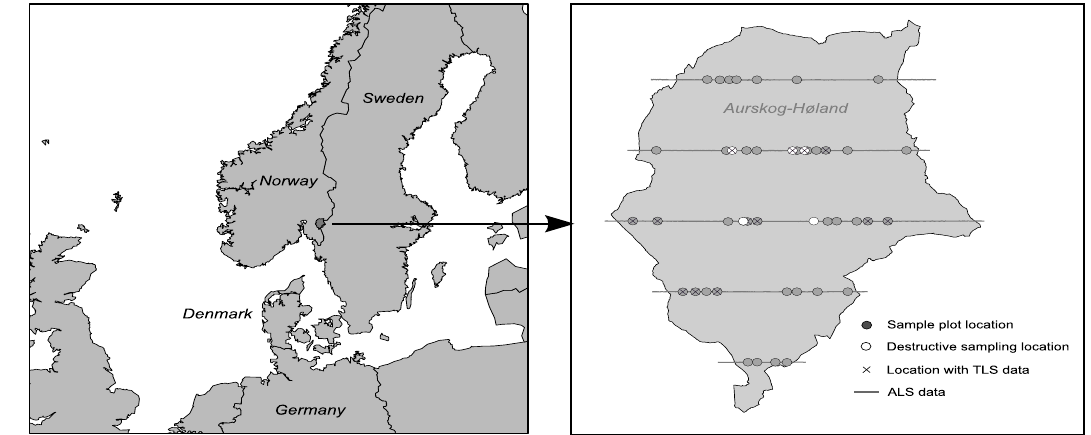
Figure 1. Location of the study area ( left ) and the locations of the field and remote sensing data within the study area ( right ). TLS, terrestrial laser scanning; ALS, airborne laser